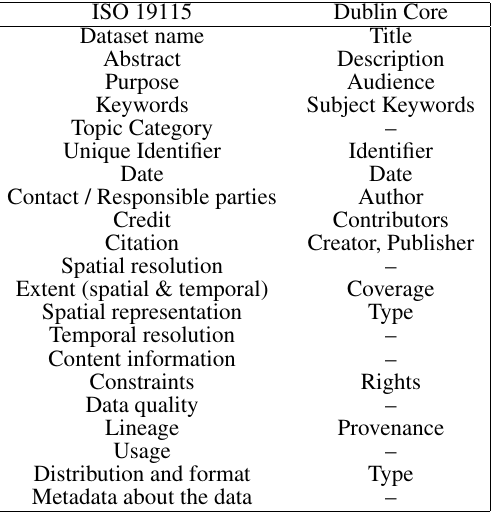
Table 1. Summary of geographic metadata